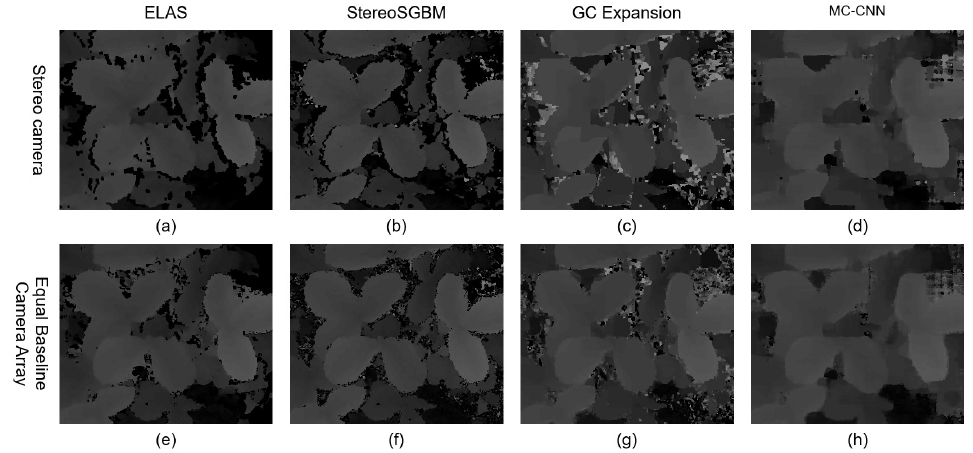
Figure 11. Disparity maps obtained using a pair of cameras ( a – d ) and EBCA ( e – h ) for the following stereo matching algorithms: ELAS ( a , e ), StereoSGBM ( b , f ), GC Expansion ( c , g ) and MC-CNN ( d , h